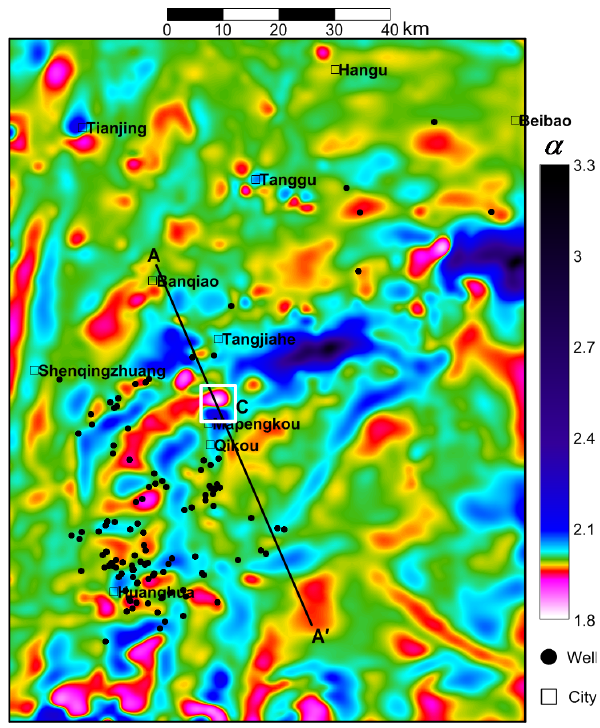
Fig. 10. Distribution of singularity indices in the aeromagnetic data; the white box indicates the seismic zone illustrated in Fig. 11.